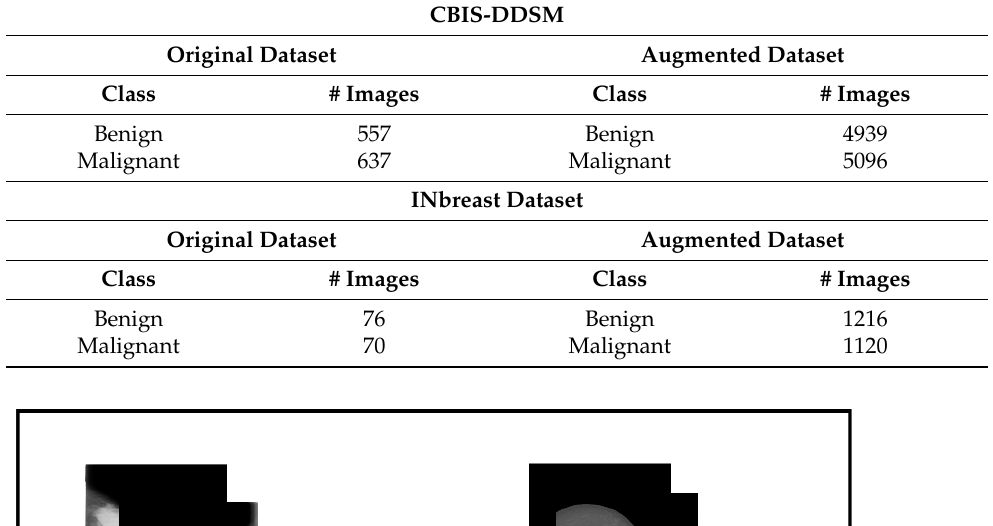
Table 1. Summary of augmented and original datasets.